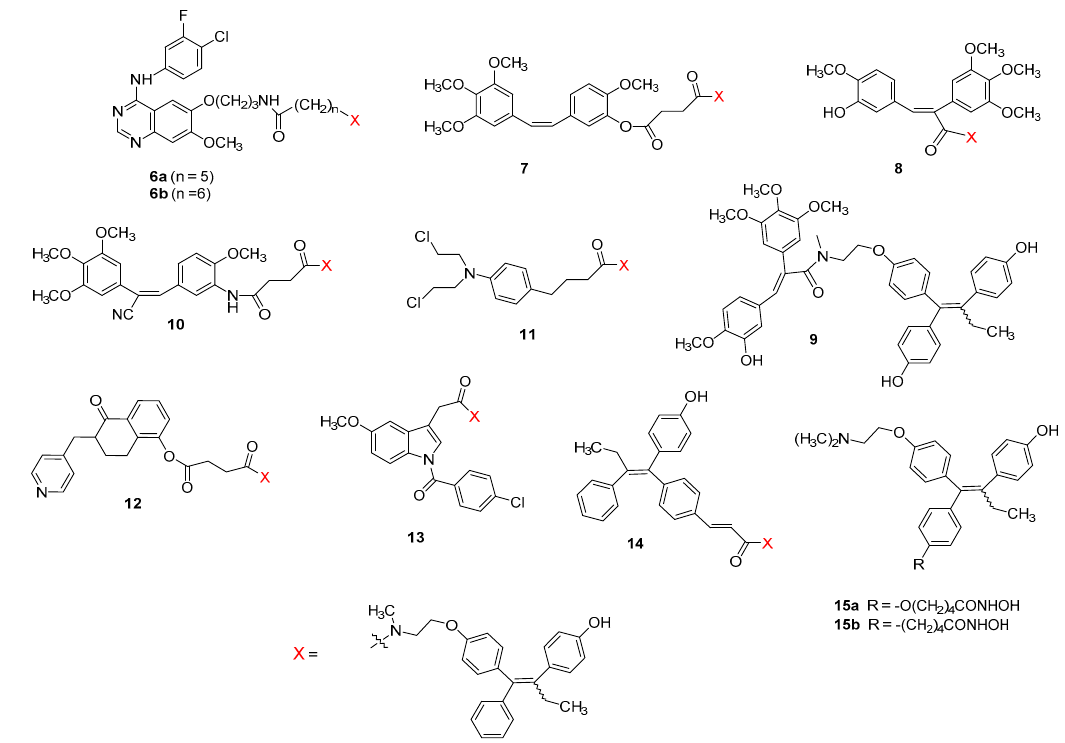
Figure 4. Structures of selected drug conjugates incorporating 4-hydroxytamoxifen. Table 3. Pharmacological actions of drug conjugates incorporating